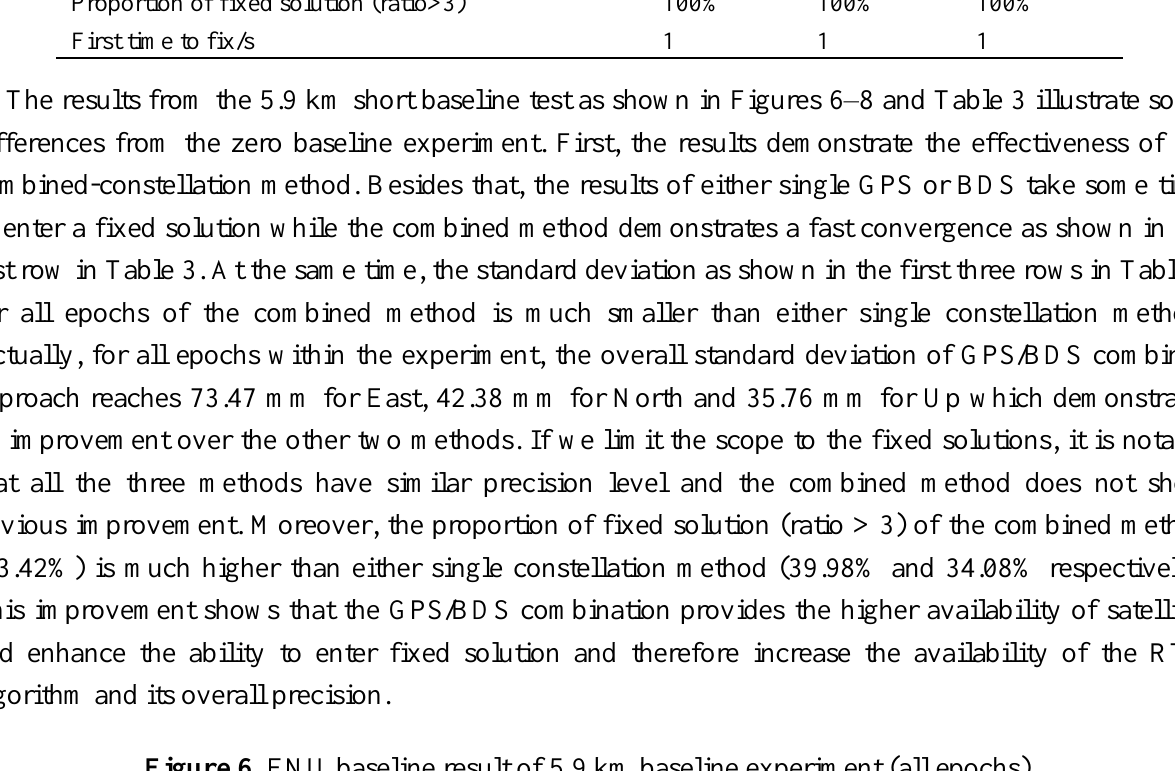
Figure 6. ENU baseline result of 5.9 km baseline experiment (all